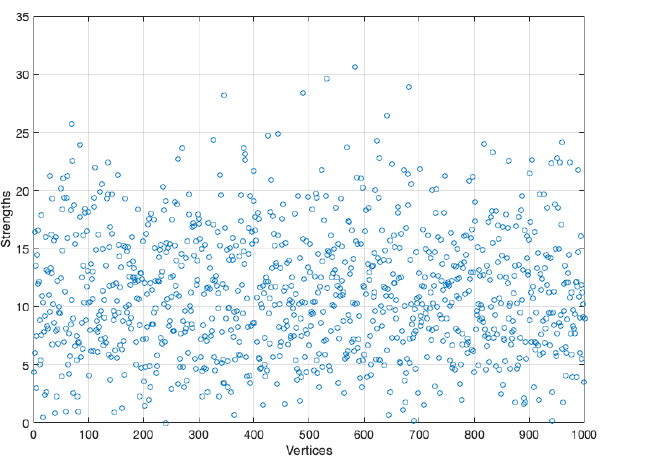
Figure 18. Strength of each